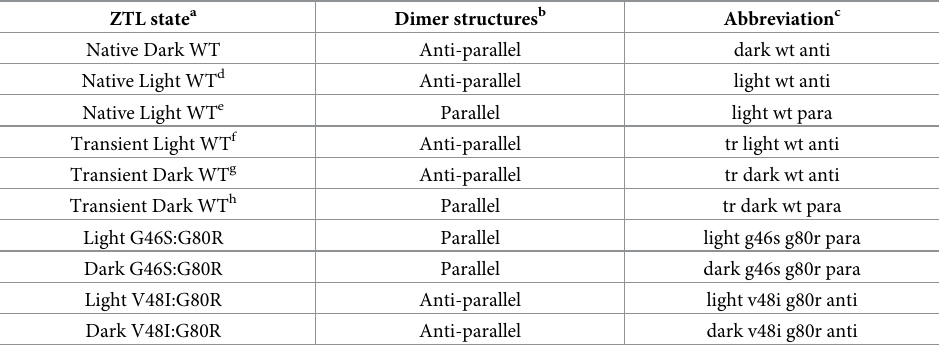
Table 1. ZTL systems subjected to